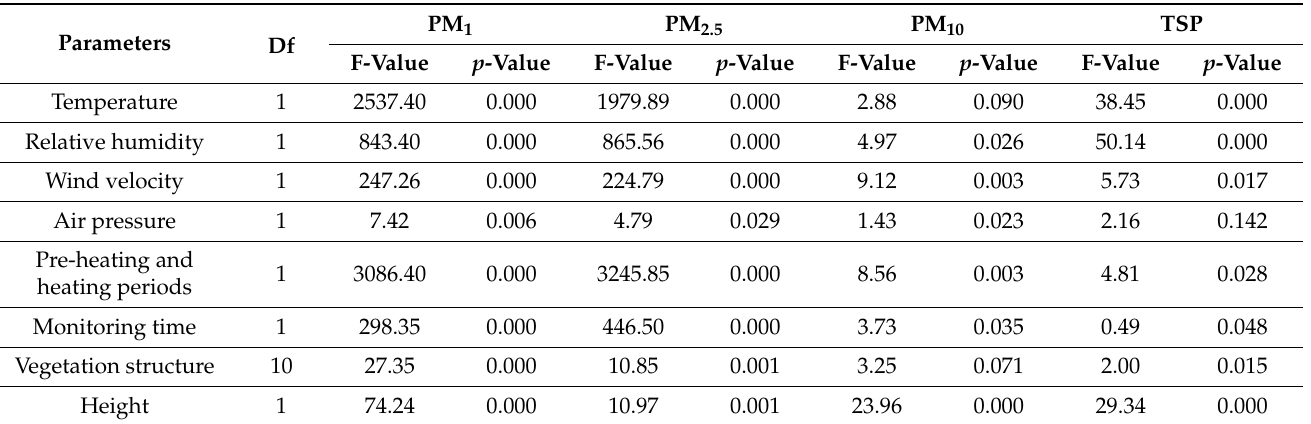
Table 2. Variance analysis of factors affecting PM